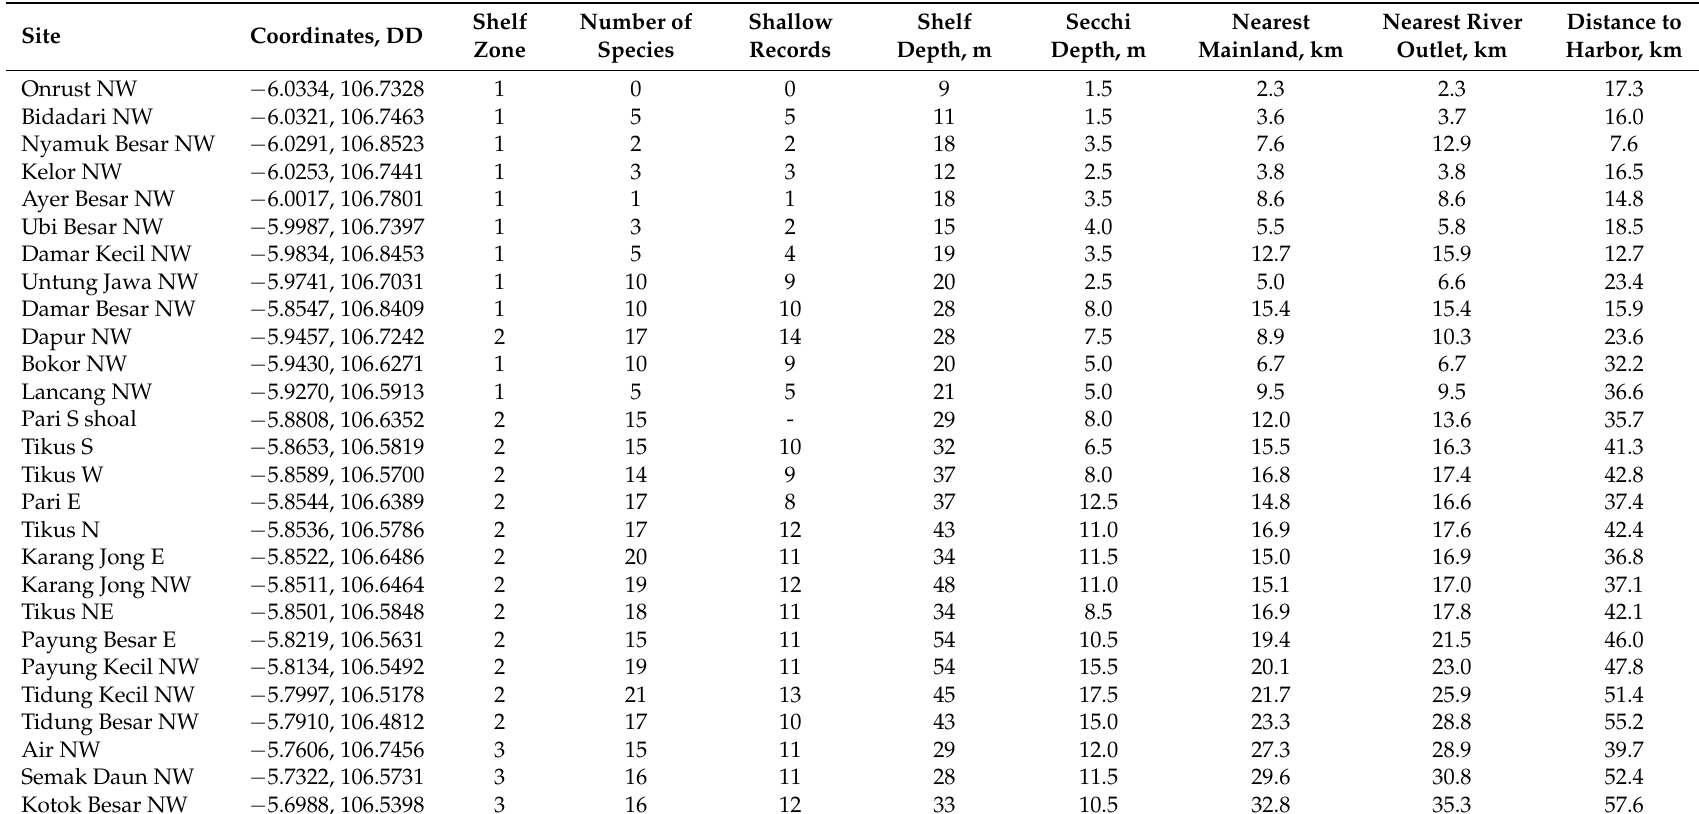
Table 1. Reef sites off Jakarta surveyed for Fungiidae with coordinates; shelf zone (Figure 1); shelf depth; secchi depth; and shortest distance to mainland, river outlet, and Tanjung Priok harbor (coordinates − 6.0932,